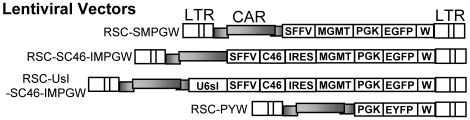
Lentiviral anti-HIV vectors.The lentiviral vector RSC-SMPGW contains an SFFV promoter (S) driving expression of the P140K mutant of MGMT (M) and also contains a human PGK promoter (P) driving expression of EGFP (G). This vector also contains a safety modified woodchuck hepatitis virus post transcriptional regulatory element (W). The following anti-HIV transgenes were added to this vector; the transmembrane-localized C46 HIV envelope fusion inhibitor expressed from the SFFV promoter with an IRES expressing MGMT (RSC-SC46-IMPGW), and the U6 driven tat/rev site I shRNA combined with the C46-expressing vector (RSC-UsI-SC46-IMPGW). The long terminal repeats (LTR) and lentiviral cis-acting region (CAR) are also indicated.